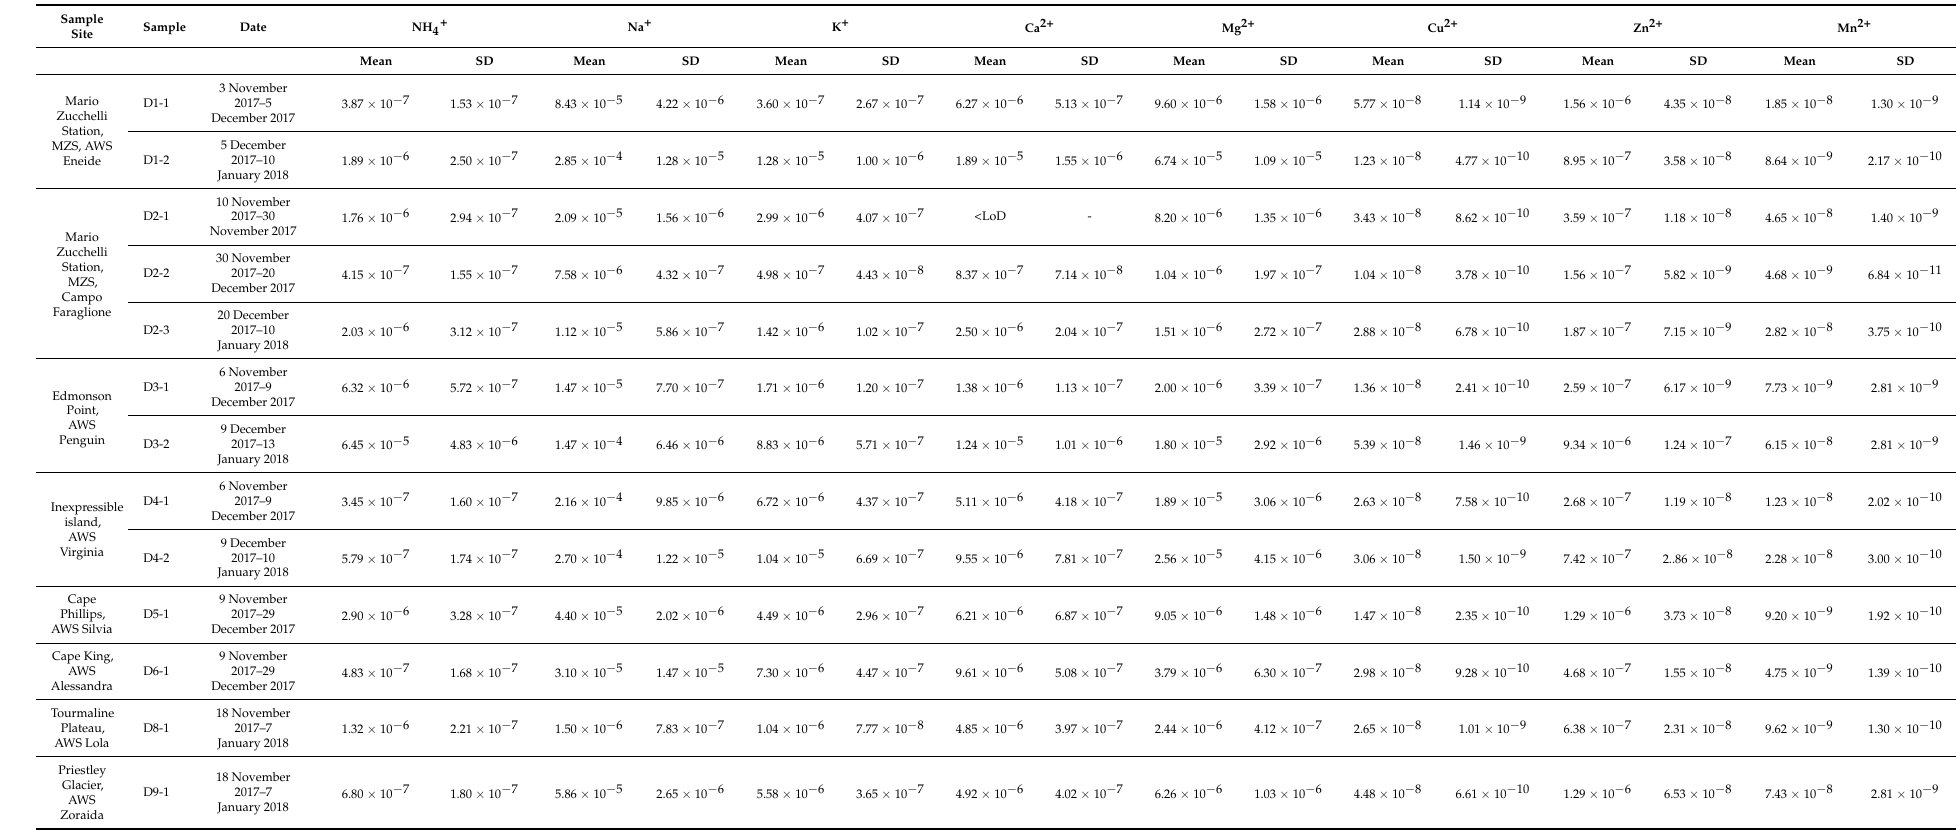
Table 4. Concentrations and corresponding standard deviations (SD) (mol L − 1 ) of the components of the atmospheric deposition